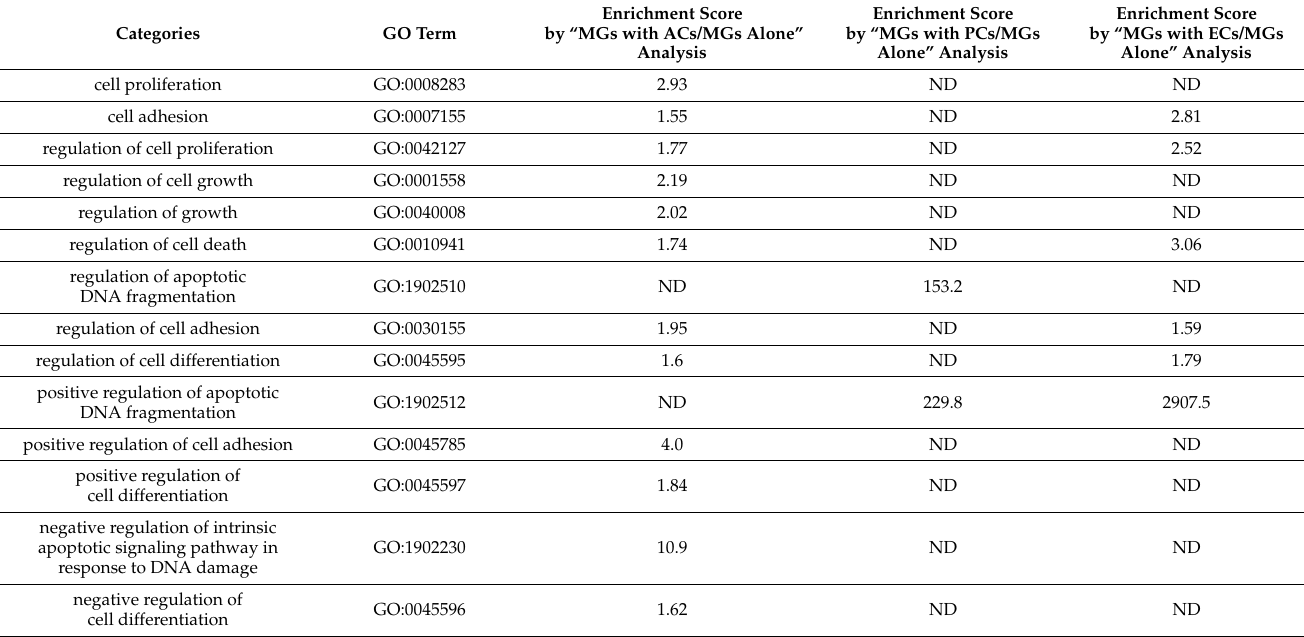
Table 1. GO analysis enrichment scores categorizing cell fate-related